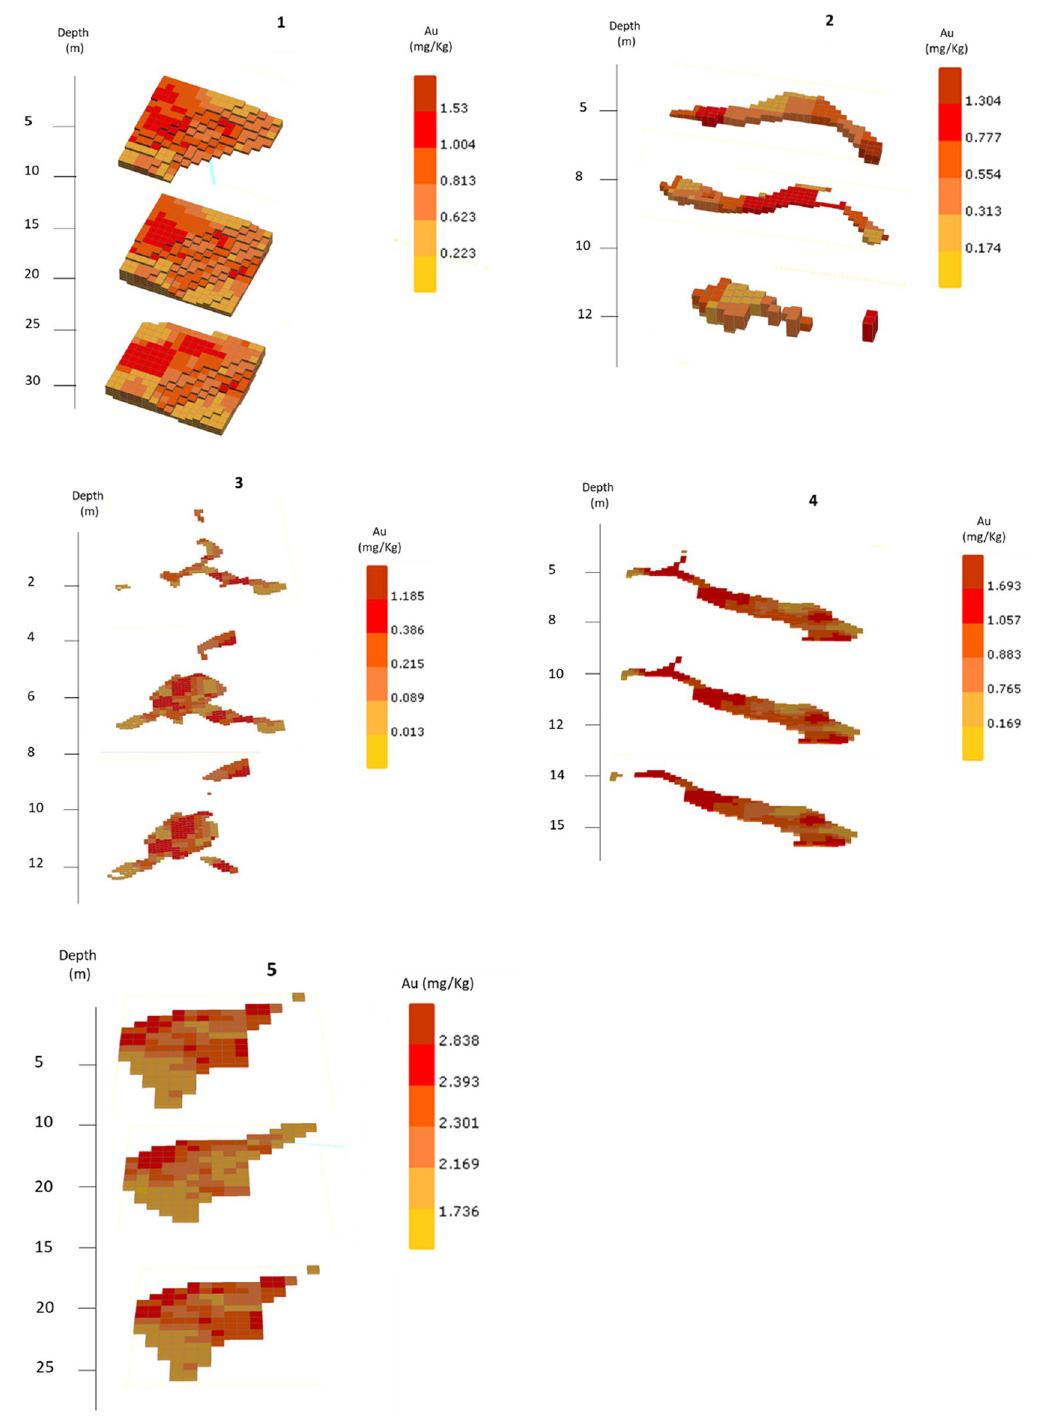
Figure 6. Spatial distribution of Au grades from 3D model by elevation and deposits 1 to